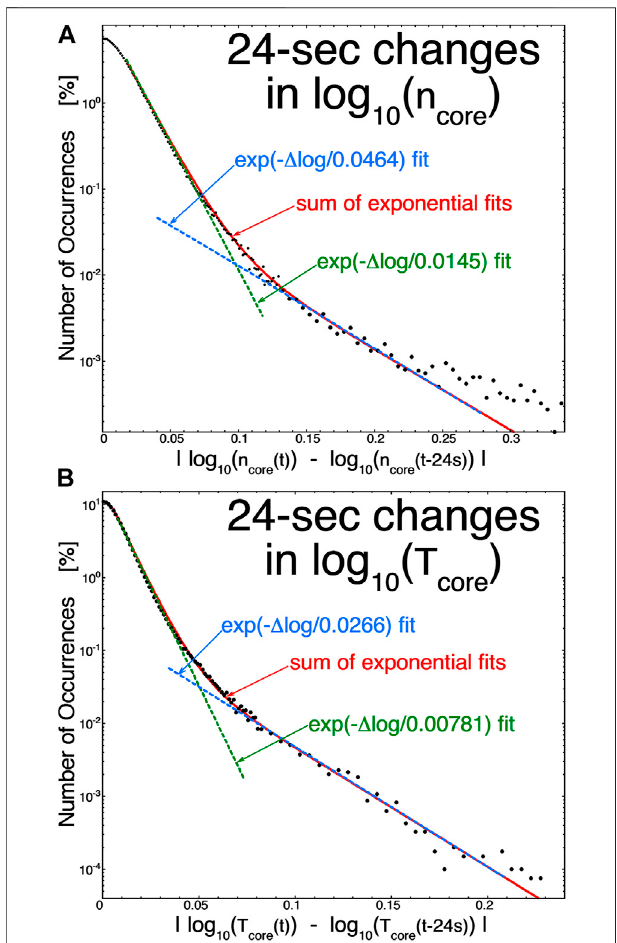
FIGURE1| Theoccurrencedistributionofthe24-schangeinlog 10 (n core ) [panel (A) ] and in log 10 (T core ) [panel (B) ] are binned for 120 days of WIND measurements at 1